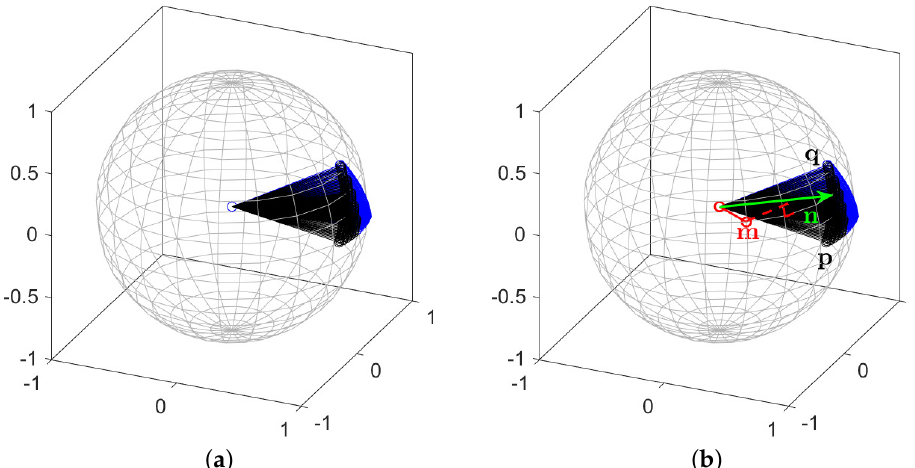
Figure 3. ( a ) All the possibilities of normal vector can be located. It is a curved triangular shape. Note that the black part corresponds to Figure 2a, and the blue part corresponds to Figure 2b. ( b ) Schematic illustration of finding the nearest normal vector n , which is represented by green color, using the projection of solar beam m , which is represented by red color, to the plane generated by any two vectors, p and q , such that lie on the nearest boundary of the region to m . Note that we normalize the magnitude of the normal